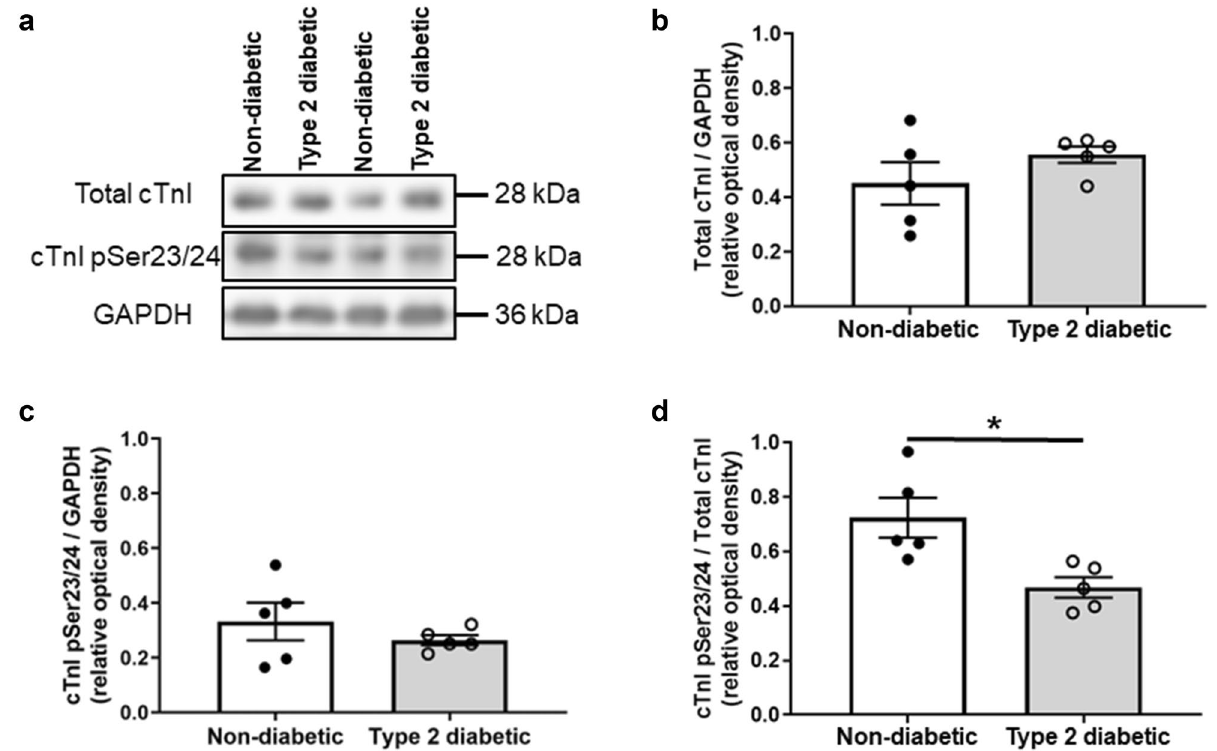
Figure 2. Protein expression of total cTnI and phosphorylation of cTnI at Ser23/24 in non-diabetic and diabetic rat left ventricular tissues. ( a ) Representative immunoblots of total cTnI, phosphorylated cTnI Ser23/24 (cTnI pSer23/24), and GAPDH in non-diabetic and diabetic rat left ventricular tissues. Quantification of ( b ) total cTnI/GAPDH, ( c ) phosphorylated cTnI Ser23/24 / GAPDH, and ( d ) phosphorylated cTnI Ser23/24/total cTnI levels in non-diabetic and diabetic rat left ventricular tissues. Data shown are means ± SEM, obtained from duplicate blots, * P < 0.05 versus non-diabetics, unpaired t-test. Original immunoblots are presented in Supplementary Fig